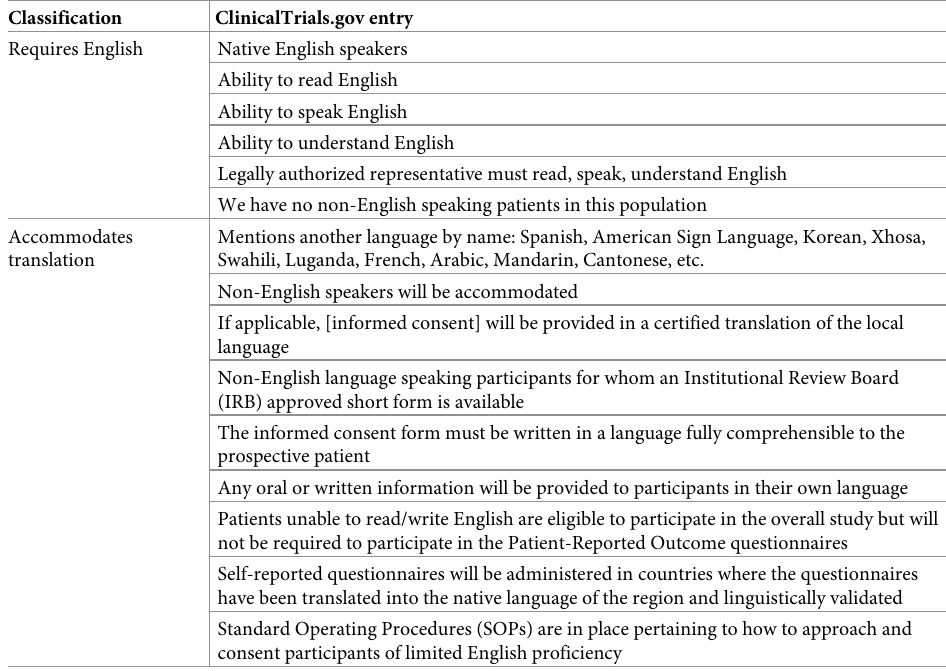
Table 1. Key phrases used to code language requirements in clinical